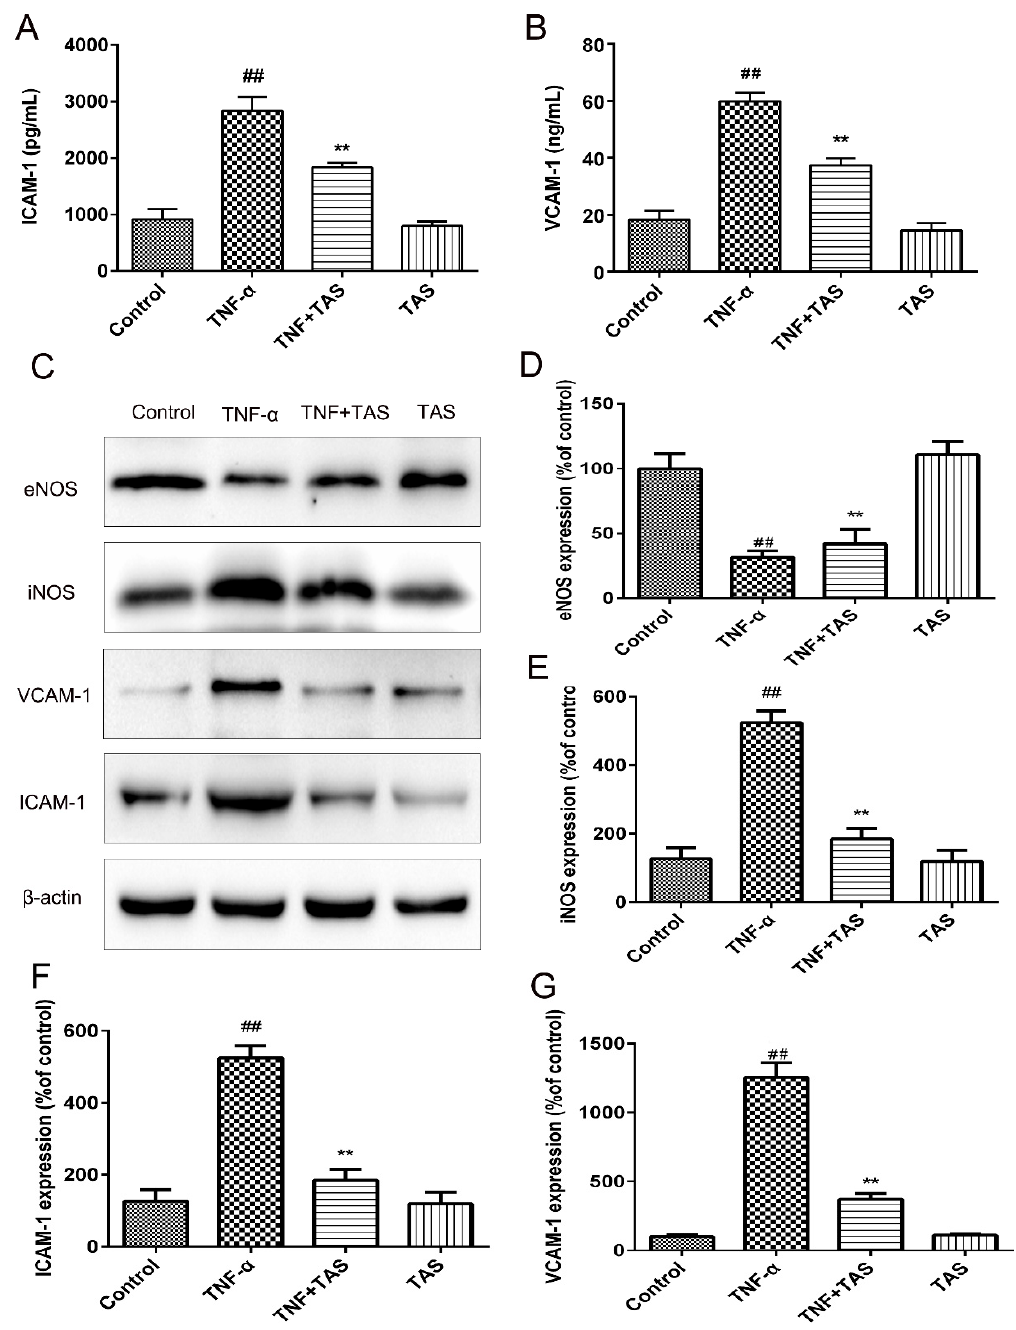
Figure 4. TAS reversed TNF- α -triggered endothelial dysfunction. HUVECs were preincubated with TAS (5 μ g/mL) for 2 h, followed by treatment with TNF- α (50 ng/mL) for 24 h. ( A ) ICAM-1 expression was detected with ELISA. ( B ) VCAM-1 expression was detected with ELISA. ( C ) eNOS, iNOS, ICAM-1 and VCAM-1 expression were examined by Western blot analysis. ( D,E,F,G) Quantitative analysis of ICAM-1, VCAM-1, eNOS and iNOS expression was performed. Each bar represents the mean ± SD of three independent experiments. ## p < 0.01 versus the control group; ** p < 0.01 versus the TNF- α -incubation group.